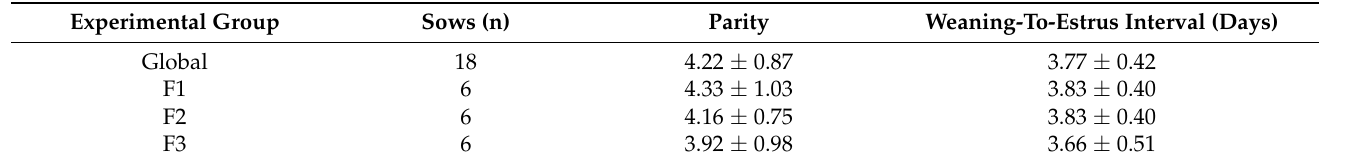
Table 1. Parity and weaning-to-estrus interval of the sows used in the experiment. Data are repre- sented as mean ± SD (standard deviation). The global group includes the data of all the sows used in the study. Experimental Group Sows (n) Parity Weaning-To-Estrus Interval (Days) Global